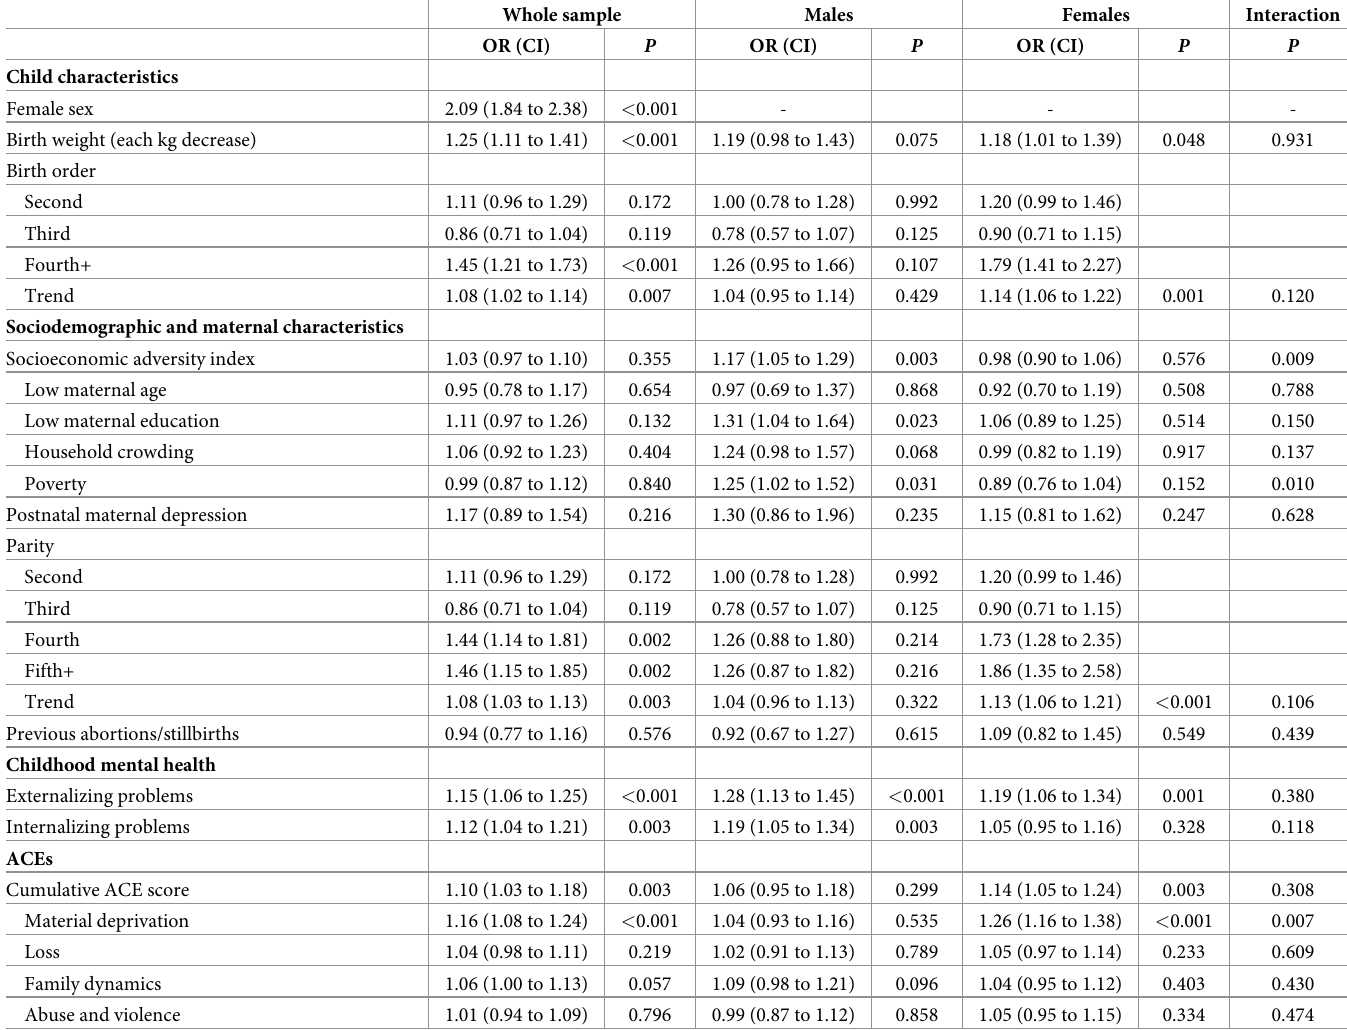
Table 3. Univariable associations between childhood factors and suicidal